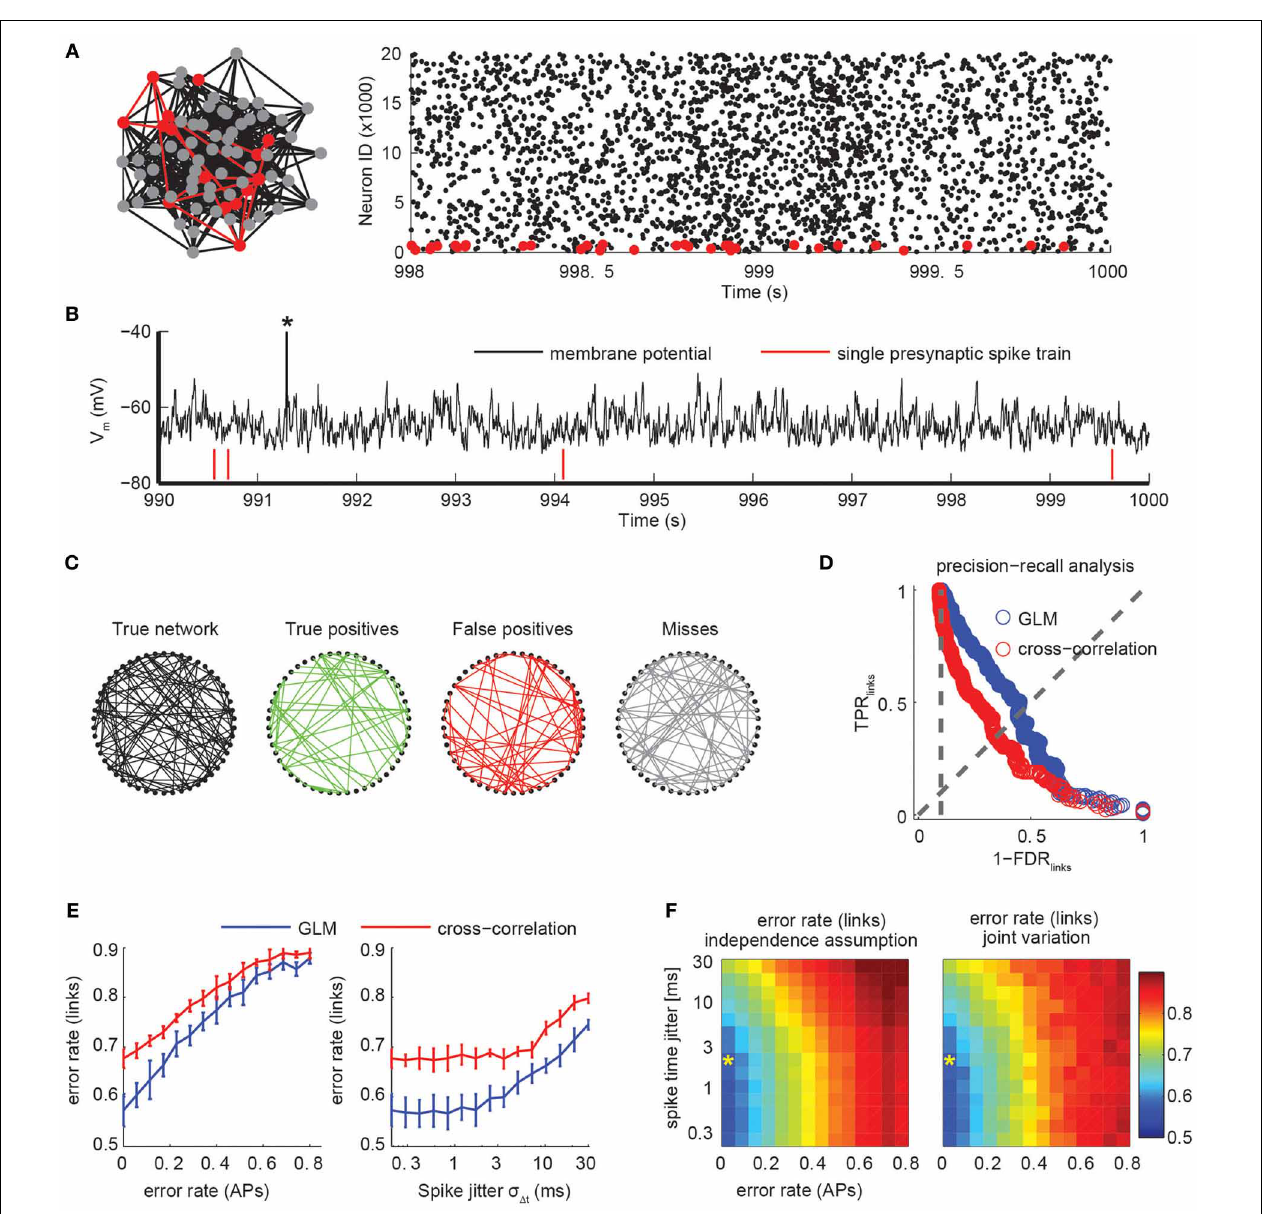
cross-correlation analysis (red). Error rate is defined as the intersection with the diagonal and is lower for the GLM than for the cross-correlation for all settings of the threshold. Chance level is indicated with the vertical, dotted line. (E) Error rates of the link reconstruction after spike perturbations for variations of the error rate in AP detection only (left, assuming no temporal jitter) and for variation of temporal precision of spike times by introducing a Gaussian jitter with width σ (cid:2) t (right; assuming zero error rate in AP reconstruction). Chance level for link reconstruction is 0.9 error rate. Error bars indicate SD over repetitions using random subsets of the network. (F) Error rate of link reconstruction as a joint function of error rate (APs) and spike jitter, assuming both effects act independently on the error rate (left) or when jointly varied (right). The similarity indicates that effects of AP detection and its temporal precision act multiplicatively on the expected error rate for link reconstruction. Asterisk indicates the performance level that is realistically achievable with state-of-the-art high speed two-photon calcium imaging (Grewe et al., 2010; Ranganathan and Koester,